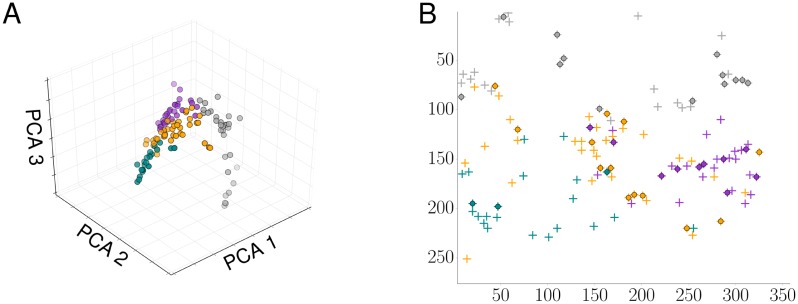
Clustering of dynamic stimuli and cell positions.(A) Weights of the three leading principal components of the stimulus data for the experiment of Fig 7. (B) Position of cells in the microfluidics chamber are shown by a plus sign. Cells that were included in the analysis, i.e. those that spiked more than 10 times, are identified by a circle. Stimuli (and hence cell positions) belonging to the same group as identified by the k-means algorithm are coloured identically and with the same colour as in Fig 7.